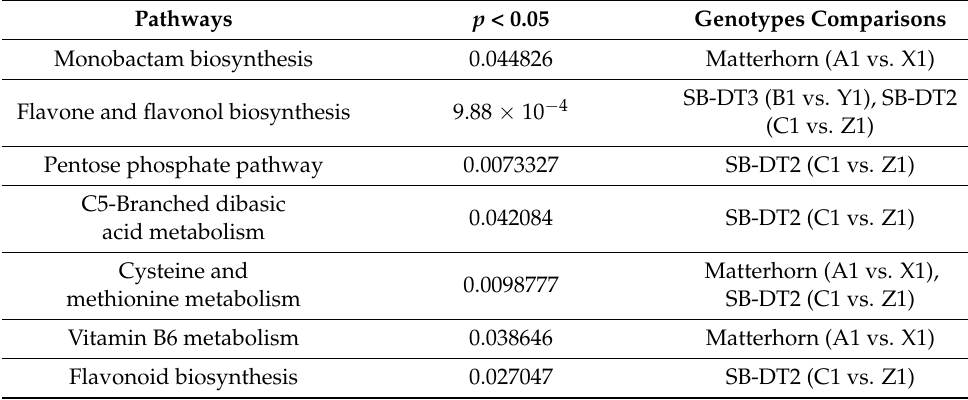
Table 3. Significant metabolic pathway with p < 0.05 across the genotype